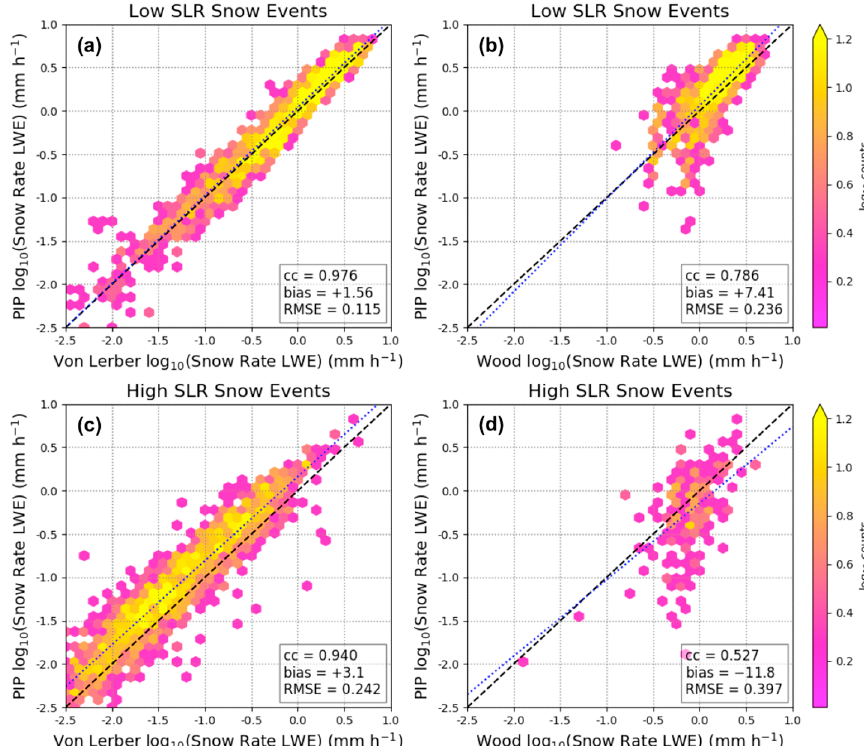
Figure 7. Shown are comparisons of the respective retrievals of snow rate (note: shown in log 10 ). The PIP-derived snow rate product is plotted along the y-axes in each panel, where the von Lerber and Wood-retrieved snow rates are plotted along the x-axes (( a , c ) and ( b , d ), respectively). ( a , b ) illustrate the results from the low SLR snow events and ( c , d ) illustrate the results from the high SLR snow events. The black dashed line represents a 1:1 relationship, while the blue dotted line is the linear regression fit to the data.